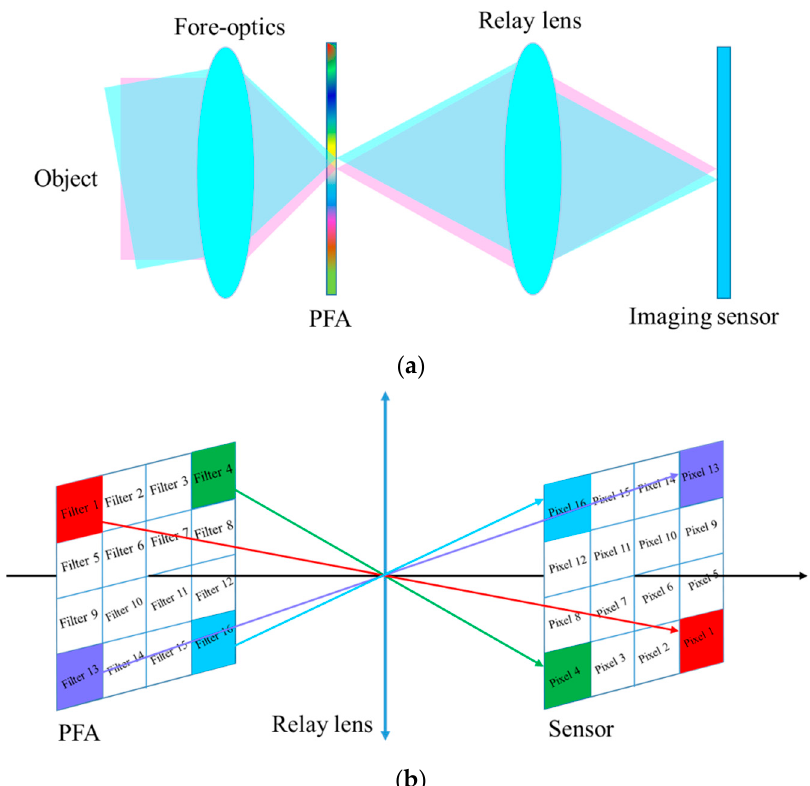
Figure 3. ( a ) Optical structure of re-imaging scheme and ( b ) one to one mapping correspondence between the filters on the PFA and pixels on imaging sensor.